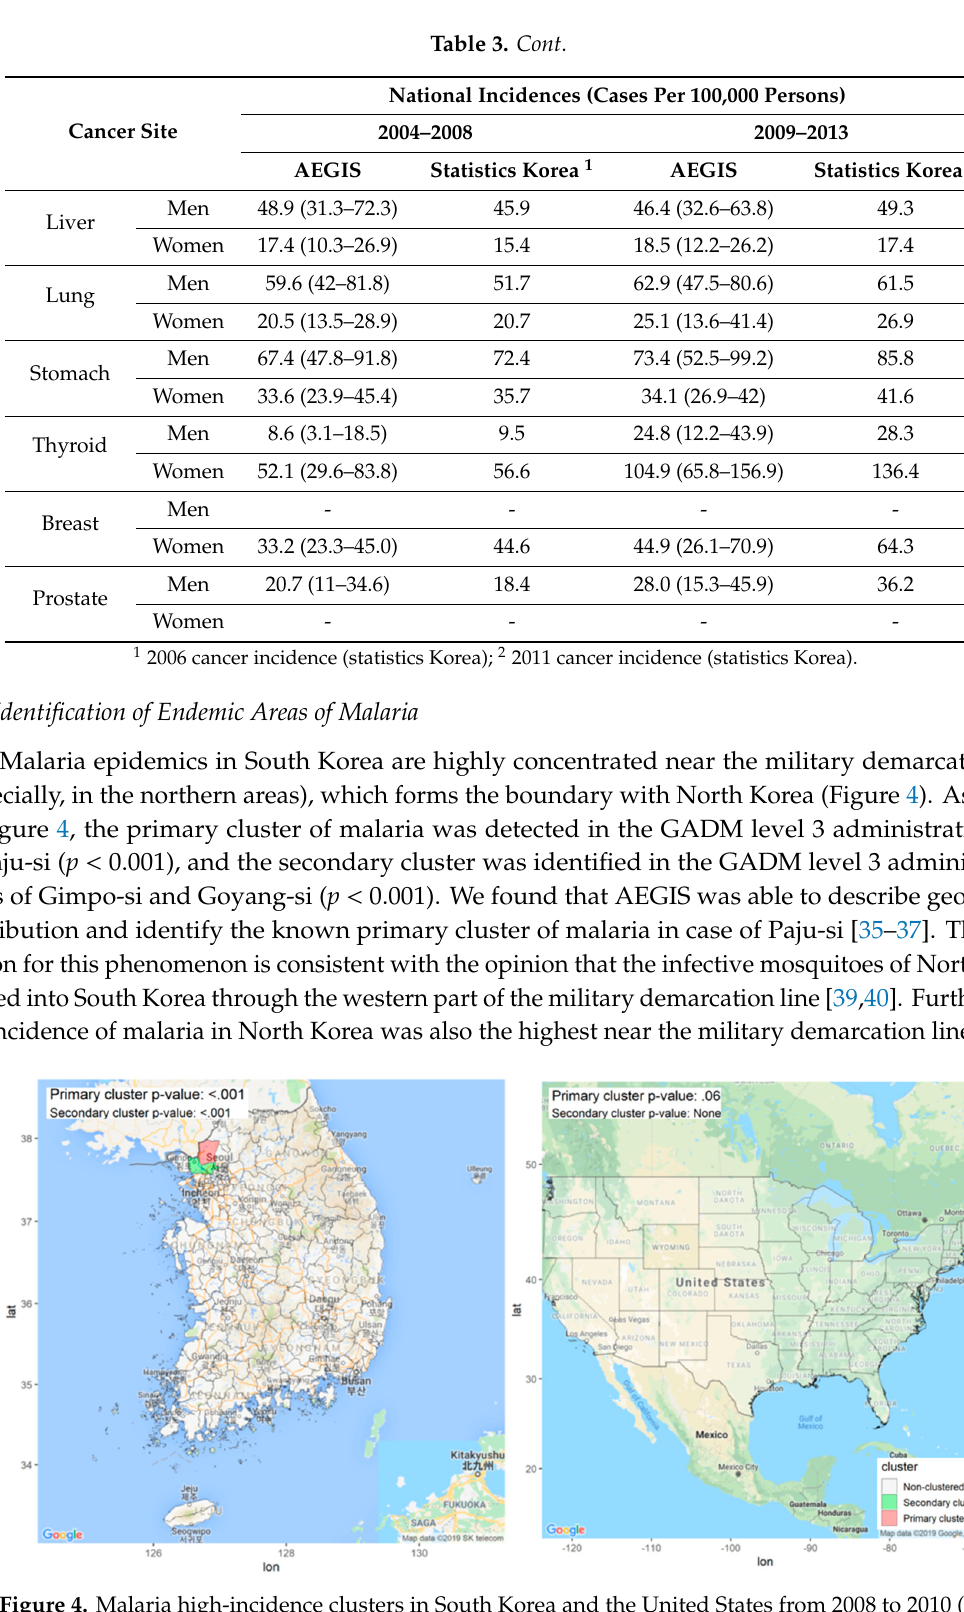
Figure 4. Malaria high-incidence clusters in South Korea and the United States from 2008 to 2010 (age and sex adjusted).